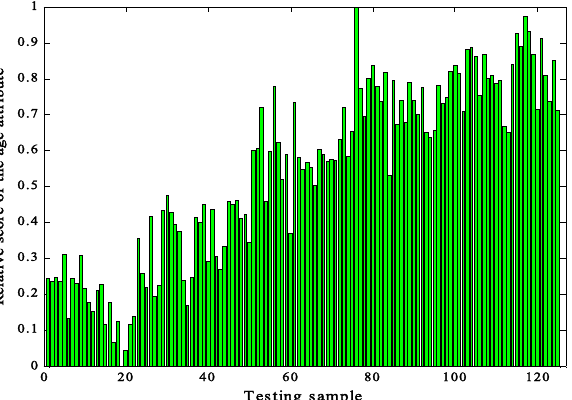
Figure 9. Relative scores of the age attribute predicted for the test TDF samples at the SRNP-EMSS. The test samples are arranged in increasing order of the five age groups, each of which has 25 con-